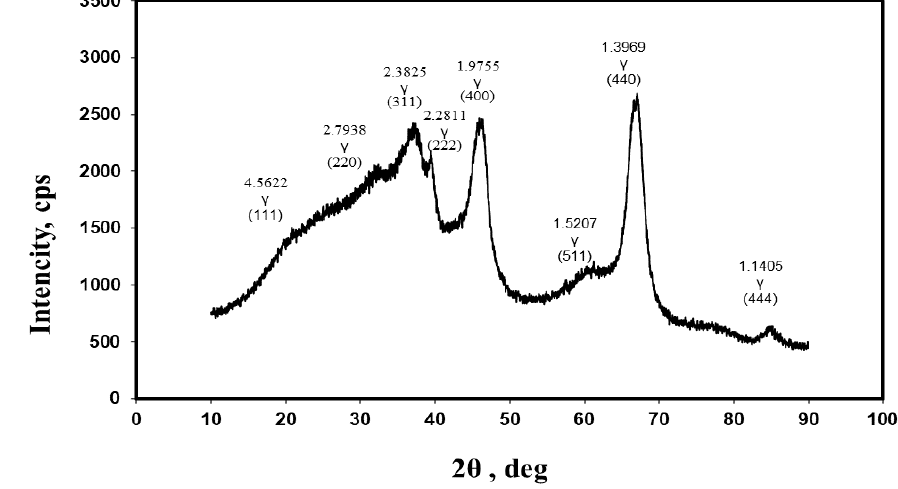
Figure 1. XRD pattern of aluminum oxide C1.